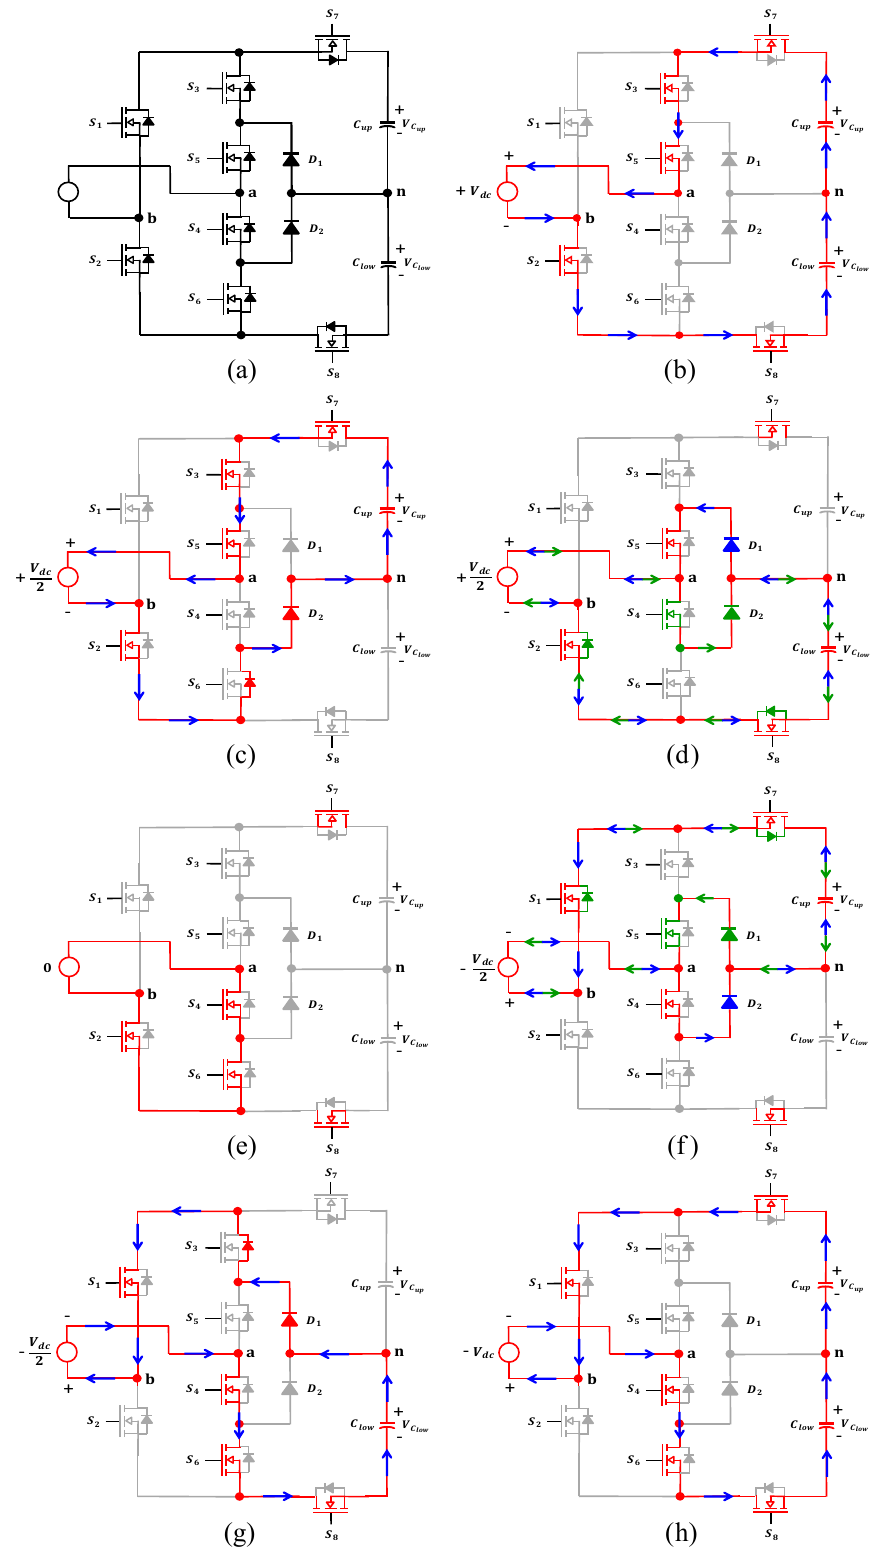
Figure 2. Current flowing paths for the seven switching states of the proposed SPFLC; ( a ) proposed topology; ( b ) State 1 [+ V dc ] ; ( c ) State 2 U [+ V dc /2 ] from upper capacitor; ( d ) State 2 L [+ V dc /2 ] from lower capacitor, ( e ) state 3 [ 0 ] ; ( f ) state 4 U [ − V dc /2 ] from upper capacitor; ( g ) state 4 L [ − V dc /2 ] from lower capacitor; and ( h ) state 5 [ − V dc ]